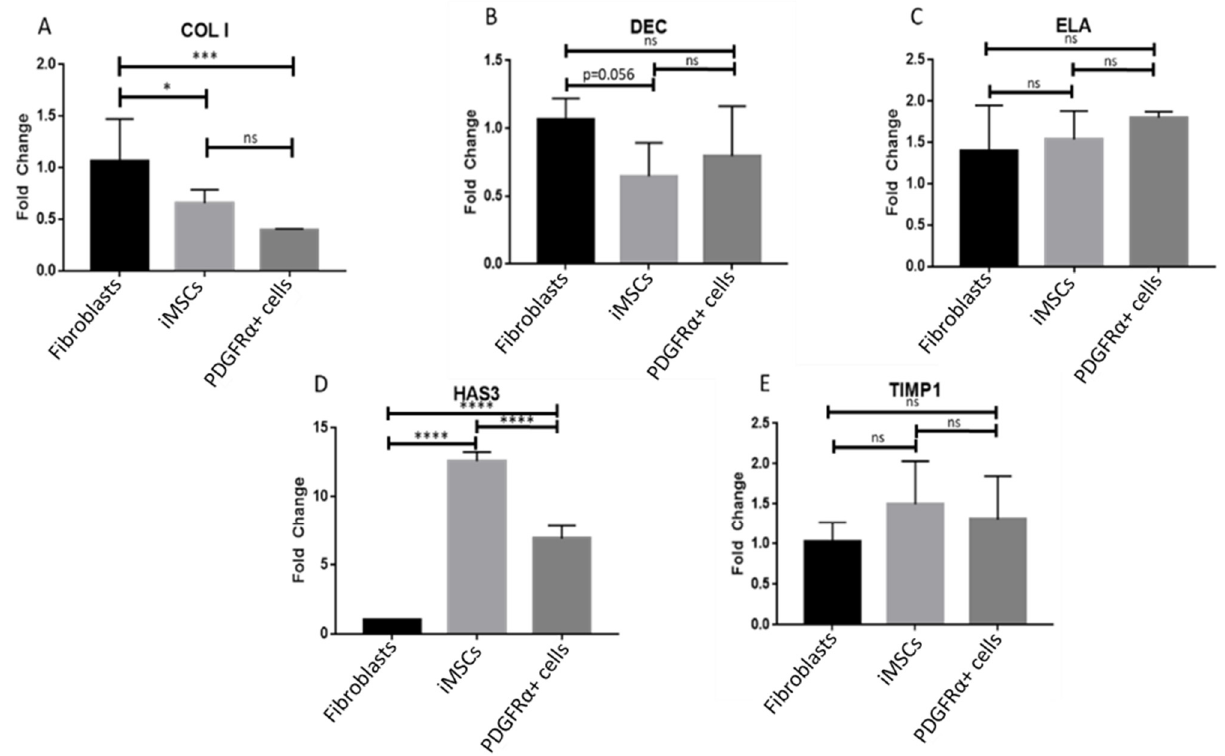
Figure 3. Gene expression of ECM proteins in fibroblasts, iMSCs, and PDGFR α -positive cells. qPCR analysis performed after 21 days of culture showed differential expression of extracellular matrix (ECM) proteins. ( A – E ). show gene expression of COL I, DEC, ELA, HAS3 and TIMP1, respectively. Gene expression of COL I was significantly different in fibroblasts compared to both iMSCs and PDGFR α -positive cells individually. Gene expression of HAS3 was significantly different between fibroblasts, iMSCs, and PDGFR α -positive cells ( n = 3, * p < 0.05, *** p < 0.001, **** p < 0.0001); ns: not significant.